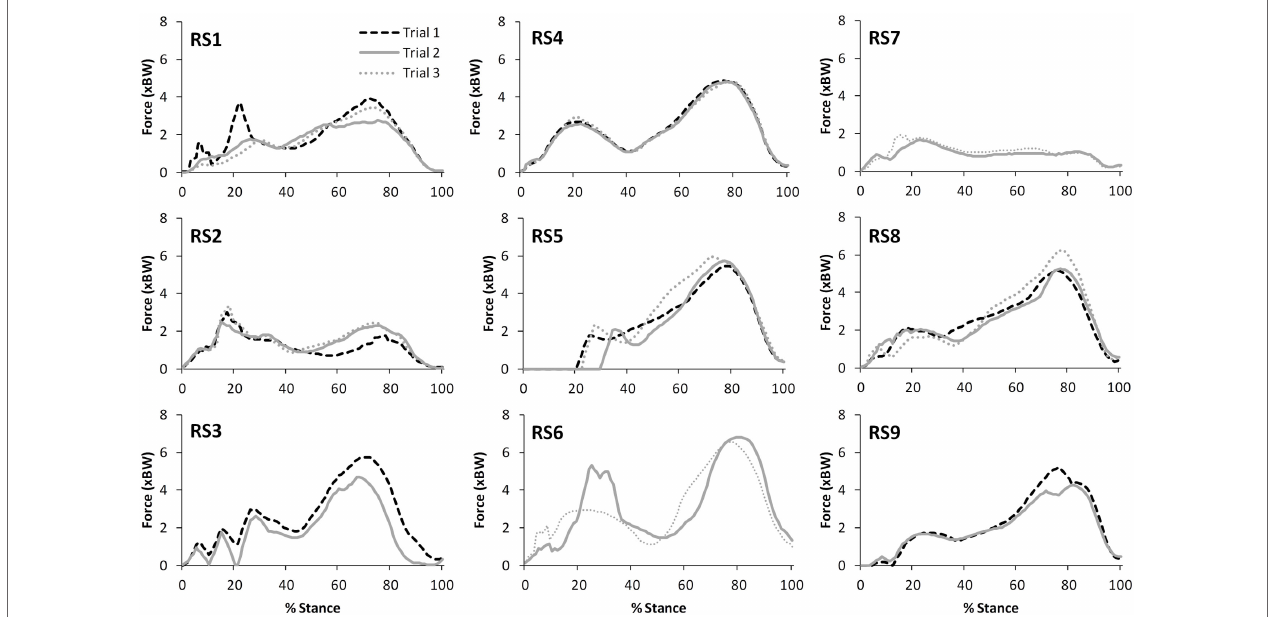
FIGURE 2 | A comparison of the subject specific variation (between the 3 trials within test session 1) in predictions of medial tibiofemoral joint contact forces during gait. Note only 2 trials were available for subjects RS3, RS6, RS7, and RS9.